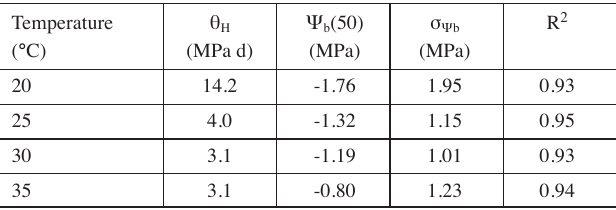
Tab. 2: Parameter estimates of the hydrotime model (Probit(g)=[(Ψ-θ H /t g )- Ψ